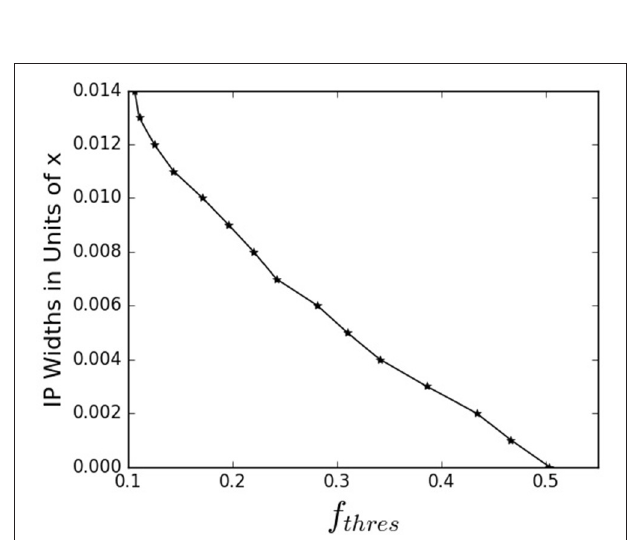
FIGURE 7 | The width of the IP in terms of composition, x , based on f thres . Given an f thres , which is a material property, this graph allows us to determine the corresponding w x if the system enables adaptable network topologies.